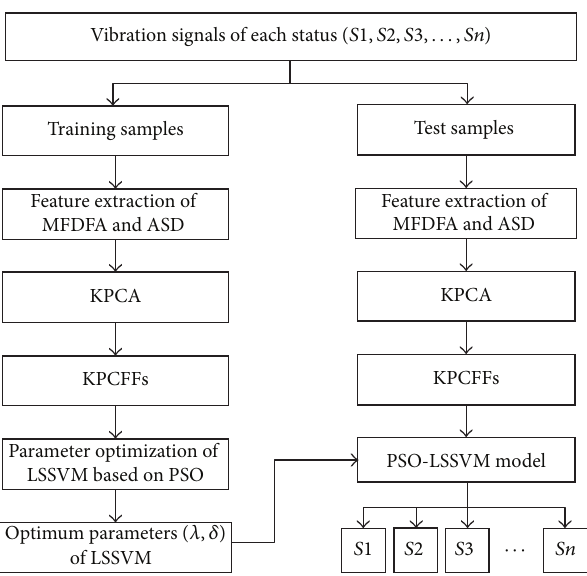
Figure 3: The diagnosis model based on feature fusion of MFDFA and